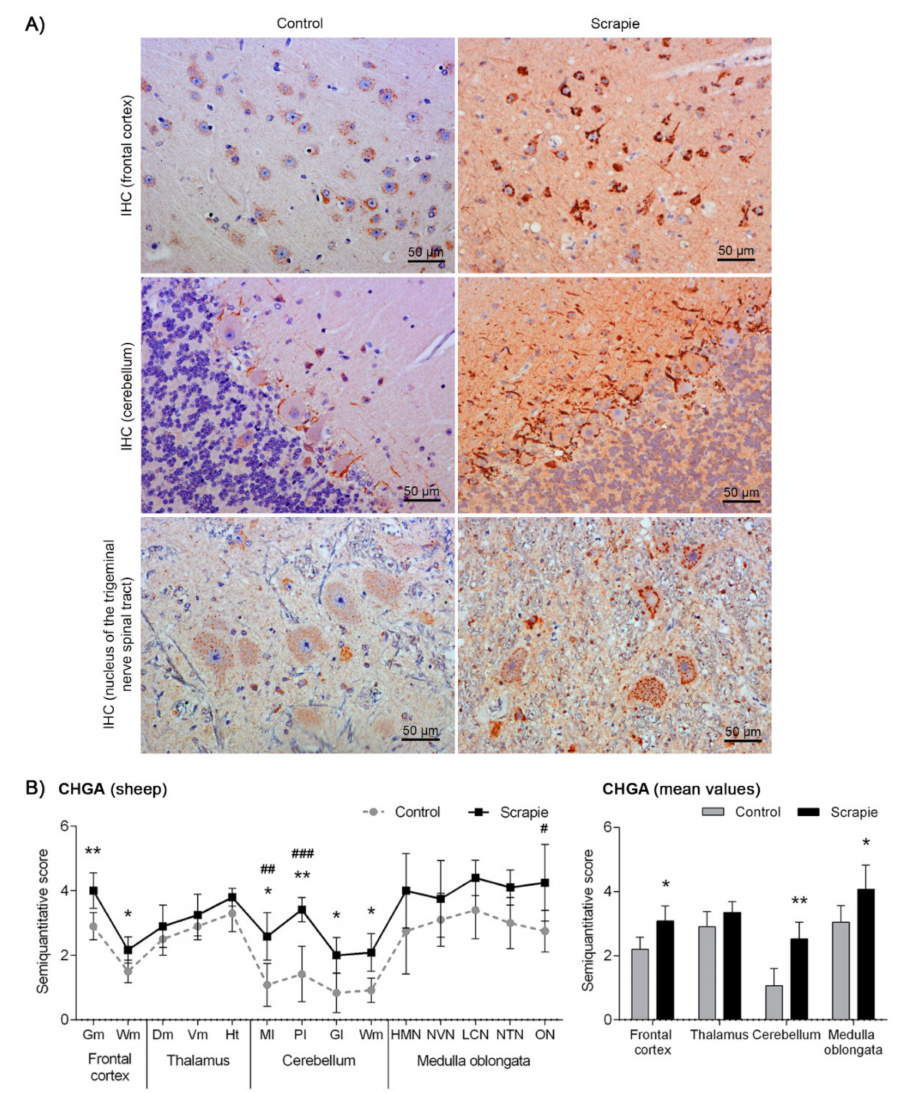
Figure 3. Immunostaining patterns and semi-quantitative scoring of CHGA in the central nervous system of scrapie-infected sheep. ( A ) Representative images of CHGA immunostaining in the frontal cortex, cerebellum and nucleus of the trigeminal nerve spinal tract (50 µ m). This protein was found forming coarse intracytoplasmic aggregates in the frontal cortex, occupying almost the entire cytoplasm, whereas it was observed as fine particulate deposits in the medulla oblongata. These granular-like deposits were more prominent and intense in the scrapie sheep group. In the cerebellum, CHGA displayed a synaptic-like and a perineuronal arrangement in the Purkinje layer, being remarkably stronger in the scrapie-a ff ected animals. ( B ) Comparative graphs between scrapie (black bars) and control sheep (grey bars). Score values (from 0: negative, to 5: staining present at its maximum intensity) evaluated in the frontal cortex, thalamus, cerebellum and medulla oblongata. Abbreviations: grey matter (Gm), white matter (Wm), dorsomedial (Dm), ventromedial (Vm), hypothalamus (Ht), molecular layer (Ml), Purkinje layer (Pl), granular layer (Gl), hypoglossal motor nucleus (HMN), dorsal nucleus of the vagus nerve (NVN), lateral cuneate nucleus (LCN), nucleus of the trigeminal nerve spinal tract (NTN), olivary nucleus (ON). Significant di ff erences were determined using the Mann Whitney U test (* p < 0.05 and ** p < 0.01). Significant di ff erences after Bonferroni correction for multiple tests are shown as # p < 0.05, ## p < 0.01 and ### p <